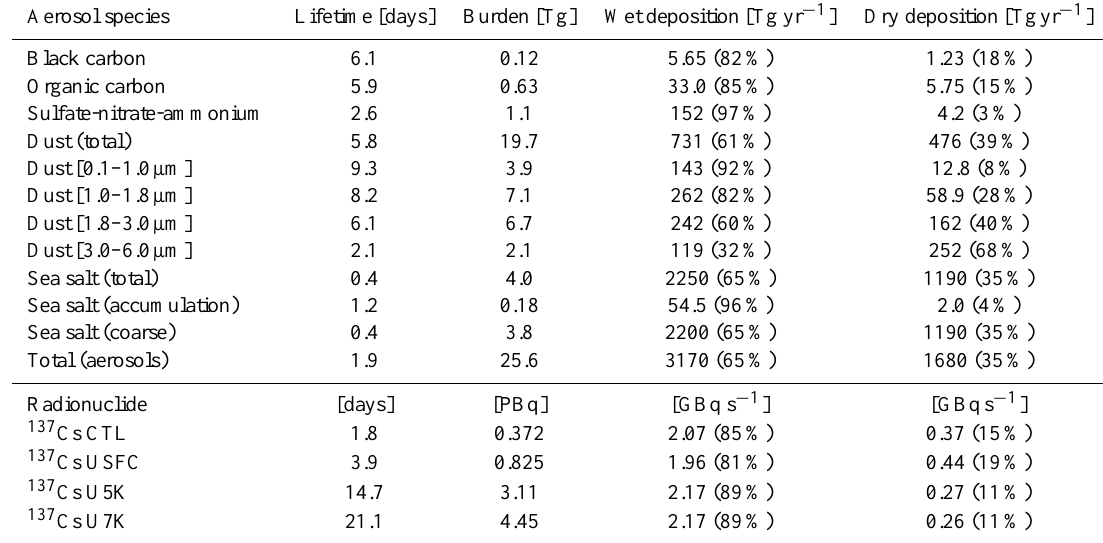
Table 2. Global and annual mean aerosol lifetimes, burdens, and deposition rates in the GEOS-Chem simulation. Round brackets indicate relative contribution to total deposition. Dust bin radii range given in square brackets. Also shown are the global, 6-month mean 137 Cs lifetime ( τ 6 mo ), burden, and deposition rates for the four simulations of this study described in Table